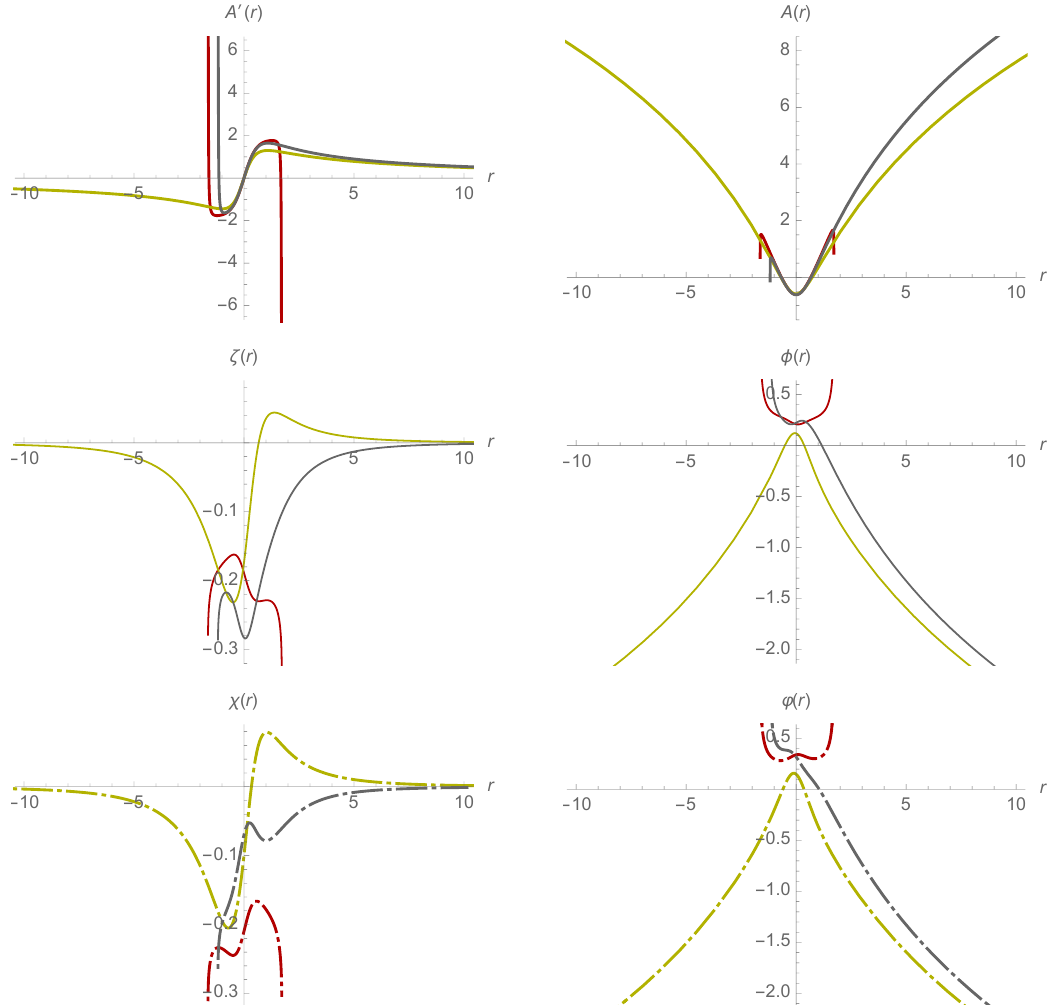
Figure 11. Examples of SYM/SYM (yellow), SYM/singularity (grey) and singularity/singularity (red) Janus solutions with N = 1 supersymmetry and SU(3)